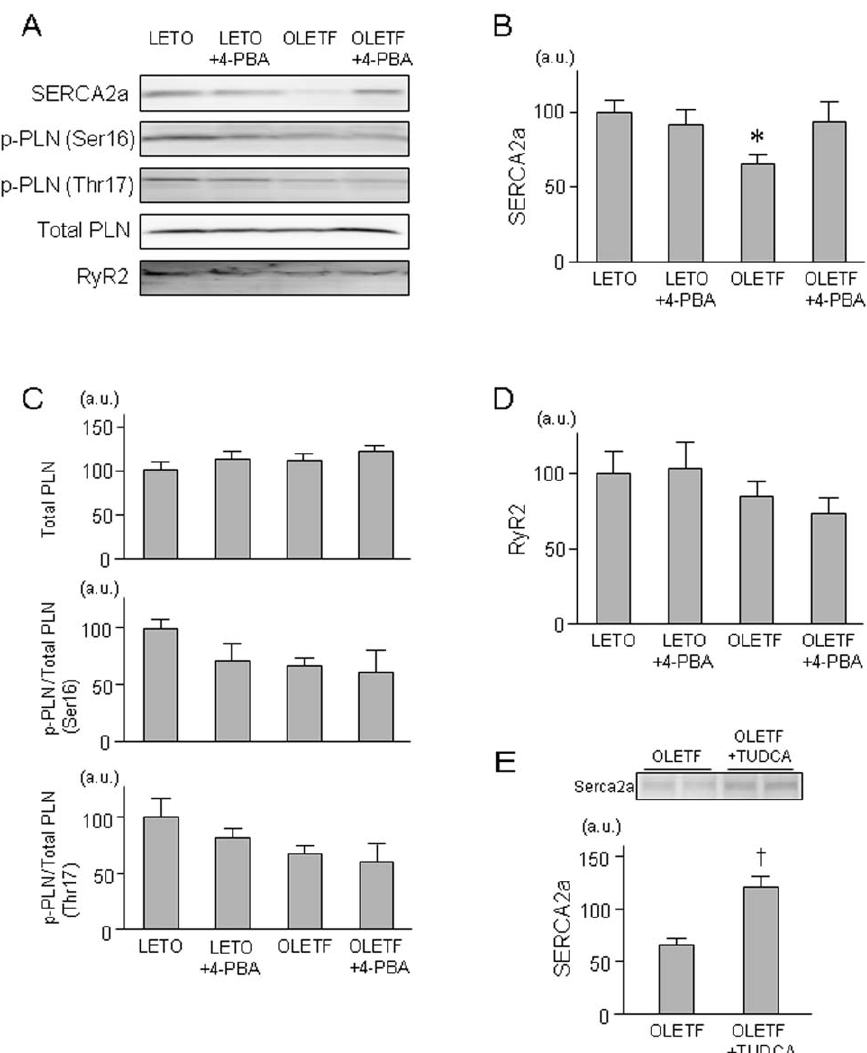
Figure 4. Sarcoplasmic proteins in OLETF and LETO. Representative blots (A) and summary of data from immnoblotting of SERCA2a (B), total PLN, and phospho-PLN at Ser16 and Thr17 (C), and RyR2 (D) are shown. n=8 , 15. Representative blots (upper panel) and summary of data (lower panel) from immnoblotting of SERCA2a (E) in a post-hoc experiment (n=5) is also shown. *p , 0.05 vs. LETO. { p , 0.05 vs. OLETF. SERCA2a= sarcoplasmic reticulum calcium ATPase 2a; PLN= phospholamban; RyR= ryanodine receptor; 4-PBA=4-phenylbutyric acid; TUDCA= sodium tauroursodeoxycholic acid.